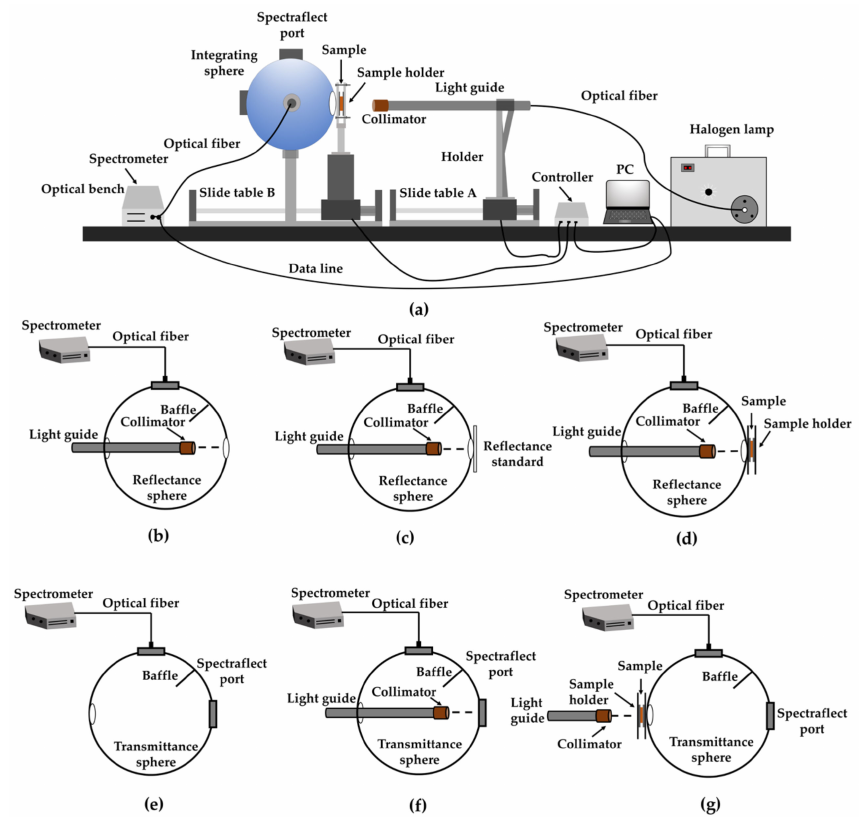
Figure 1. Illustration of the setup of automatic single integrating sphere ( a ), and the schematics for measurementsonthereflectanceofdarknoise R d ( b ), reference R r ( c )andsample R s ( d ), thetransmittance of dark noise T d ( e ), reference T r ( f ) and sample T s ( g